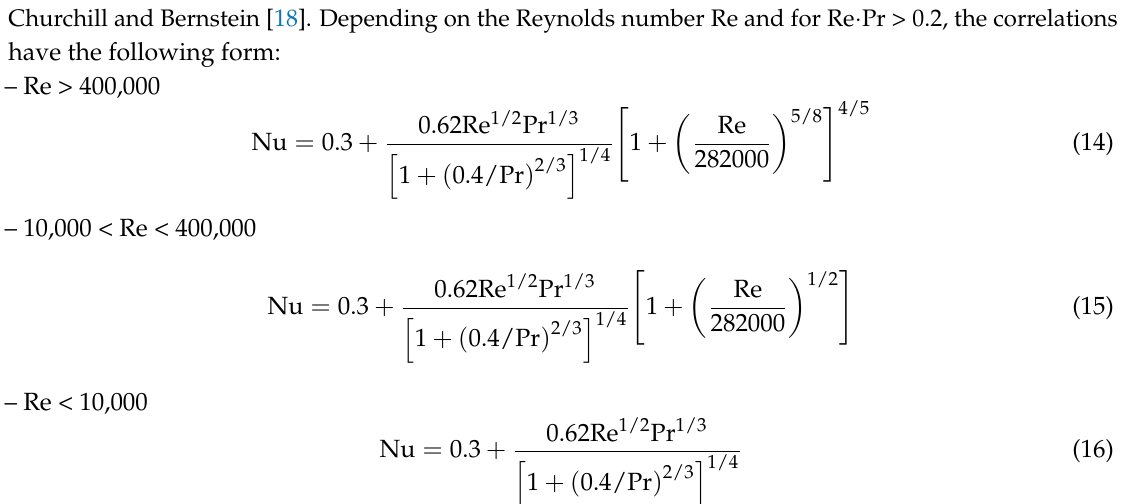
Figure 3. Fluid temperature and the temperature “measured” at the axis of the 15 mm diameter thermometer and on its outer surface—comparison of the exact temperature with the results obtained from the solution of the inverse problem for the linear rise in fluid temperature.